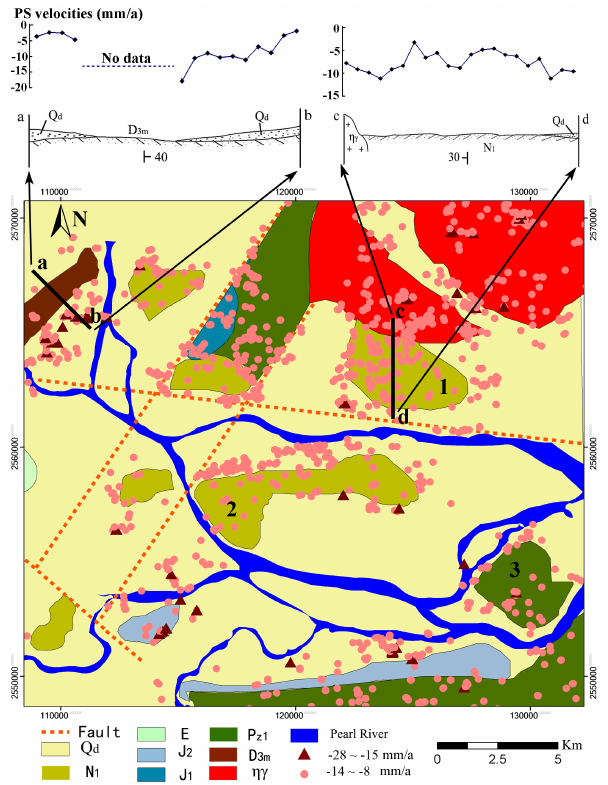
Fig. 4. Geological relationship with ground displacement in Guangzhou, covering same area as Fig. 3a. Instead of the two groups of faults, the distribution of Quaternary deposits, especially to the boundary of Quaternary sediments and late Tertiary rocks, is highly related to significant displacements ( < − 8mma − 1 ) val- idated by the results in Guangzhou ( Q d : Quaternary deposits, in- cluding gravel, sand and clay; N 1 : Neogene-Miocene conglom- erate, sandstone and shale; E : Paleogene-Eocene conglomerate, sandstone and limestone; J 2 : Jurassic-middle conglomerate, sand- stone and shale; J 1 : Jurassic-early conglomerate, sandstone and shale; P z 1 : Permian-late shale, sandstone and siltstone; D 3m : Devonian-late sandstone, shale and siltstone; ηγ : mica granite dur- ing Yanshanian period between Jurassic and early-Cretaceous). The profile sections of a–b and c–d are examples of rock distribution, geological and the PS deformation velocities relationships, demon- strating the correlation between the boundary of different geologi- cal units (i.e. Quaternary distribution or old rocks) and significant displacement trends.